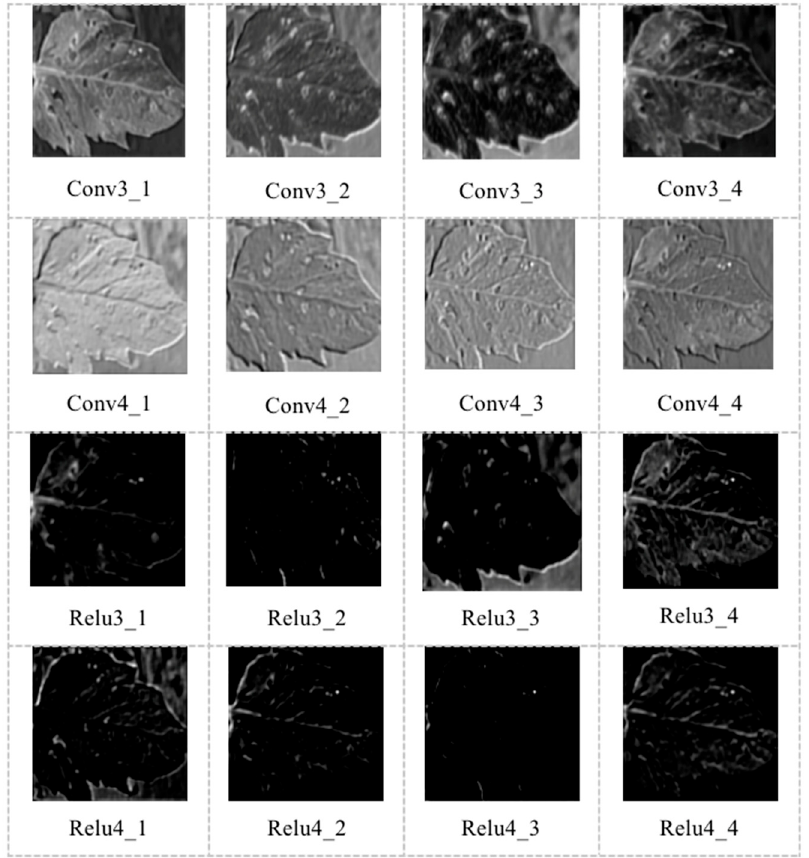
Figure 10. Output features of Conv3-4 and Relu3-4 layers.